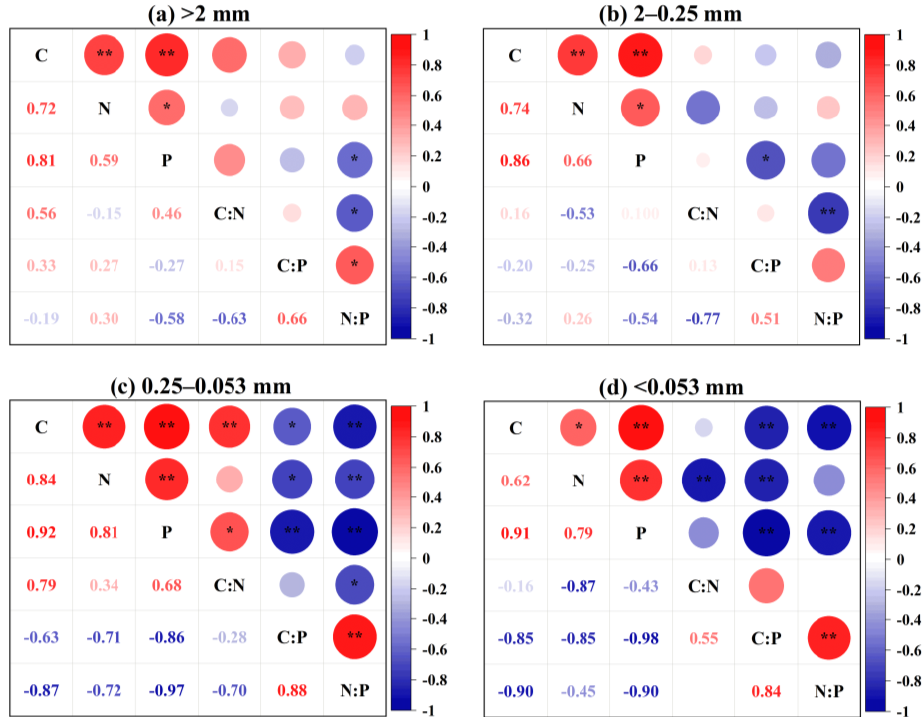
Figure 5. Correlation analysis between nutrients and stoichiometry in soil aggregate. ( a ) >2 mm; ( b ) 2–0.25 mm; ( c ) 0.25–0.053 mm; ( d ) <0.053 mm. Red circles represent positive correlation and blue circles represent negative correlation. The size of the circle is proportional to the r value. *, p < 0.05; **, p < 0.01. The correlation coefficients are in the lower left panel. C (SOC); N (TN); P (TP); C:N (SOC/TN); C:P (SOC/TP); N:P (TN/TP).